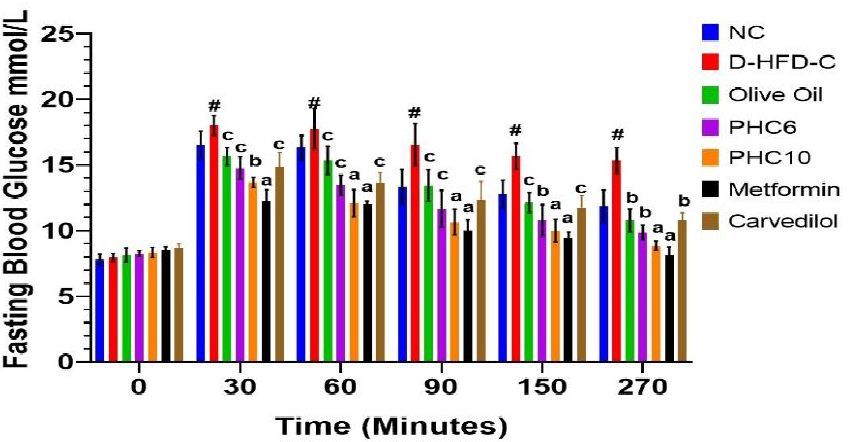
Figure 11. Fasting blood glucose level for OGTT. All values are expressed as mean ± SD ( n = 6) analyzed by one- way ANOVA followed by Tukey’s t -test. D-HFD-C was compared with NC ( # p < 0.0001), and the values were found to be highly significantly different. The different treatment groups were compared with D-HFD-C and the results were found to be different at the following significance levels: c p < 0.01; b p < 0.001; a p < 0.0001 from the respective disease control groups. NC is normal control; D-HFD-C is diabetic high-fat diet control group; PHC6 and PHC10 are the poly- herbal combination treated groups.].